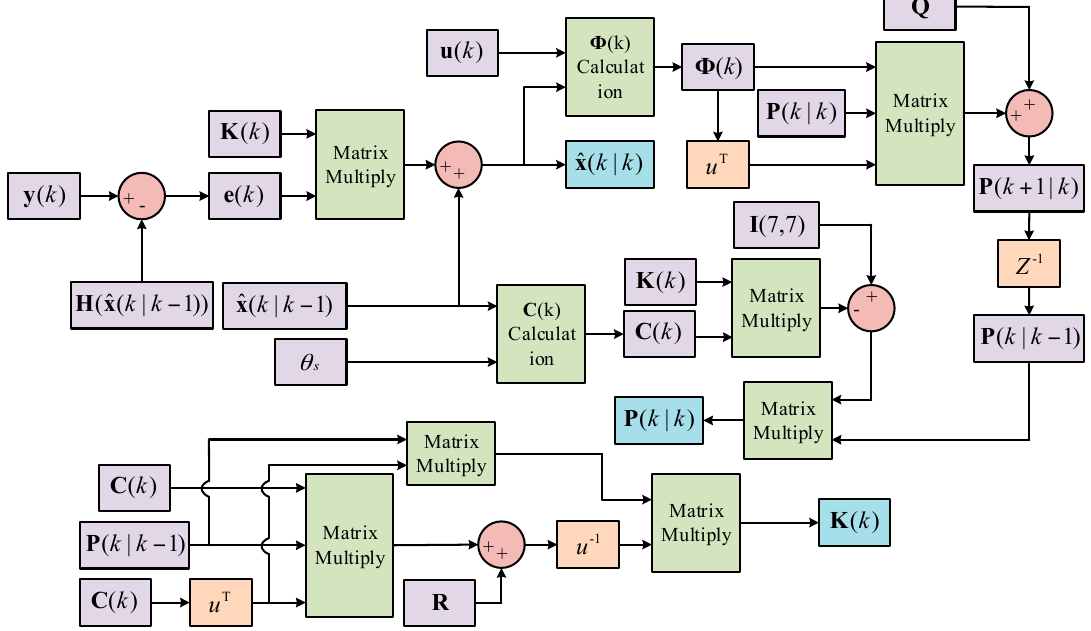
Figure 3. EKF algorithm for the seventh-order DFIG model.